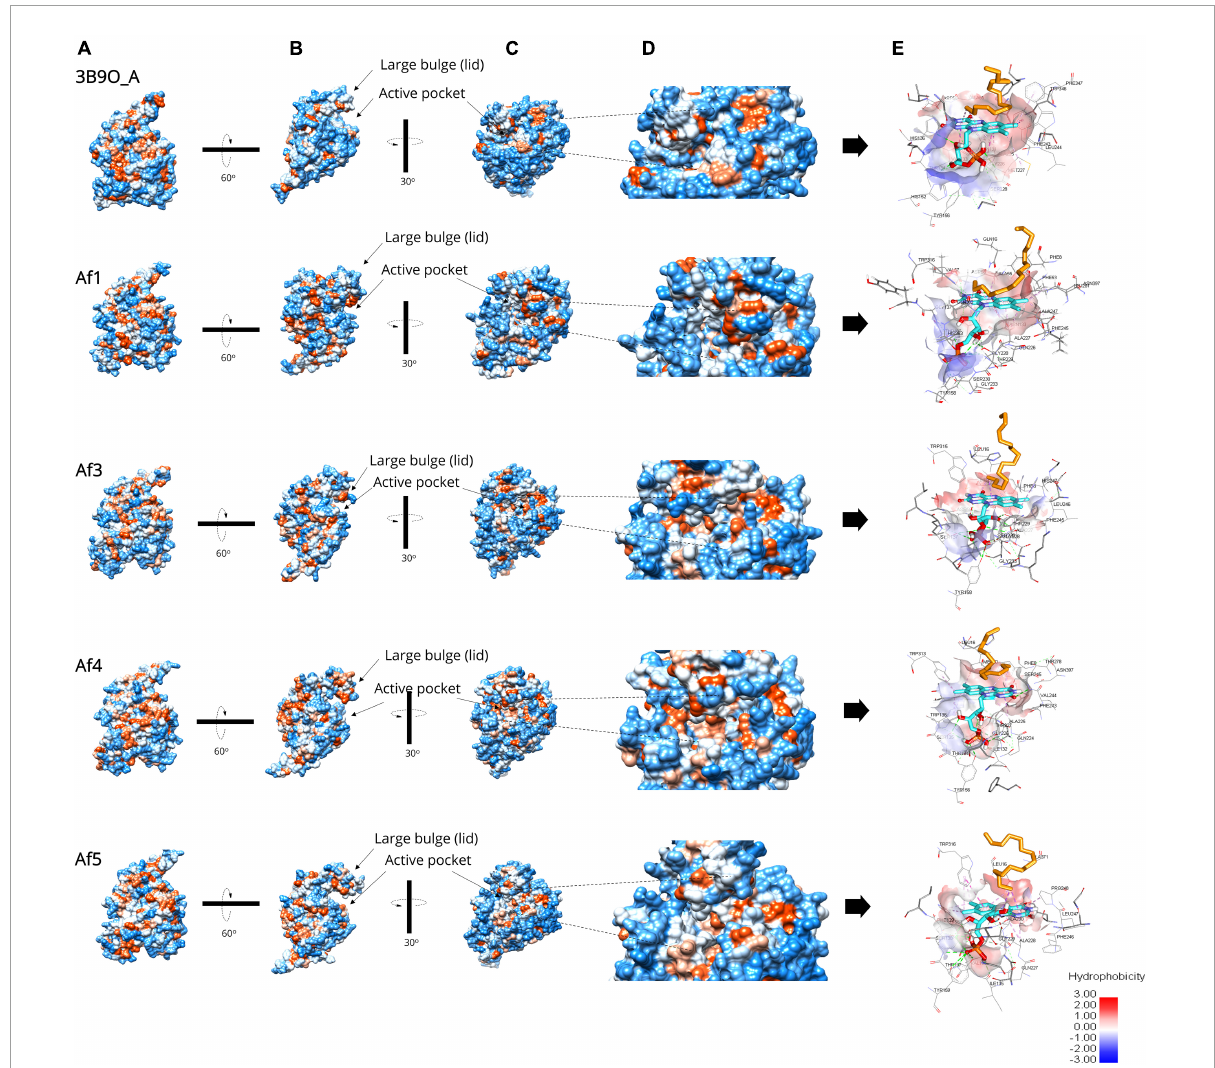
FIGURE3 Surface representation of the predicted A. flavus LadA α homologs Af1 , Af2 , Af4 , and Af5 enzymes and the active pocket compared to the G. thermodenitrificans LadA (3B9O chain A) crystal structure (Li et al., 2008) analyzed by UCSF Chimera (Pettersen et al., 2004) v1.1. and BIOVIA Discovery Studio Visualizer (Biovia, 2015). (A) The five structures aligned in the same view; hydrophobicity is depicted by color range from red ( + ) to blue ( − ). (B) Illustrates the large bulge (lid) gating the underlying active pocket. (C) A detailed view of the active pocket inside the enzyme. (D) The enlarged view of the active pocket inside the enzyme. (E) Illustration of the inner surface of the active pocket, alkane (orange), FMN (cyan), active site amino acids